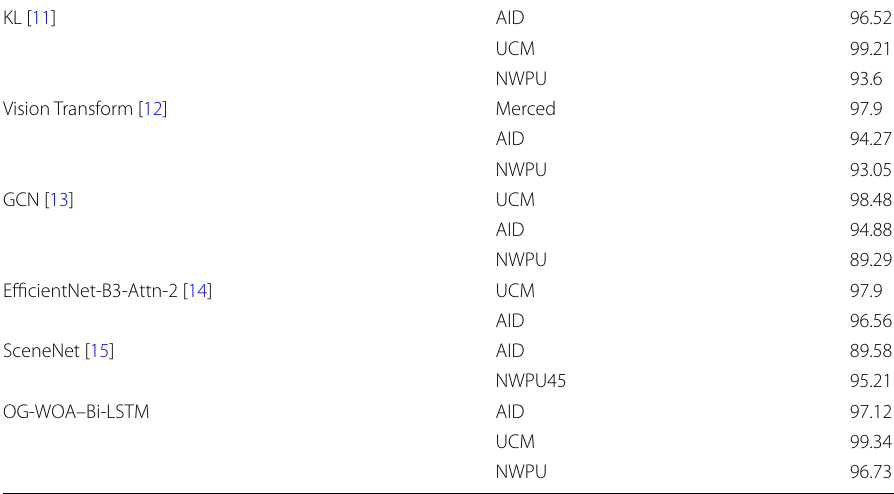
Table 7 Comparative accuracy (%) analysis for satellite image classification KL [11] AID 96.52